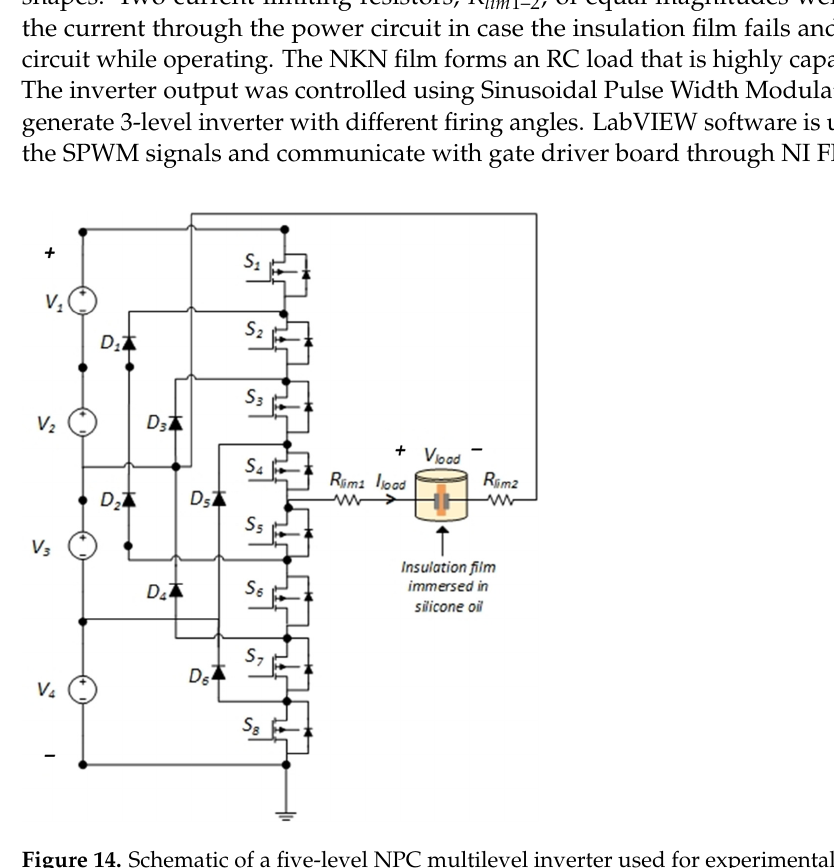
Figure 15. Experimental setup—NPC multilevel inverter.